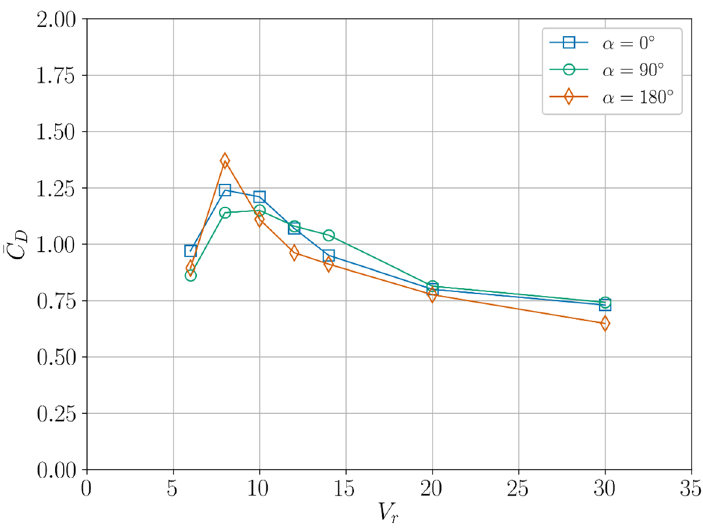
Figure 17. Mean inline force coefficient of FOWT platform under different current incidence conditions.